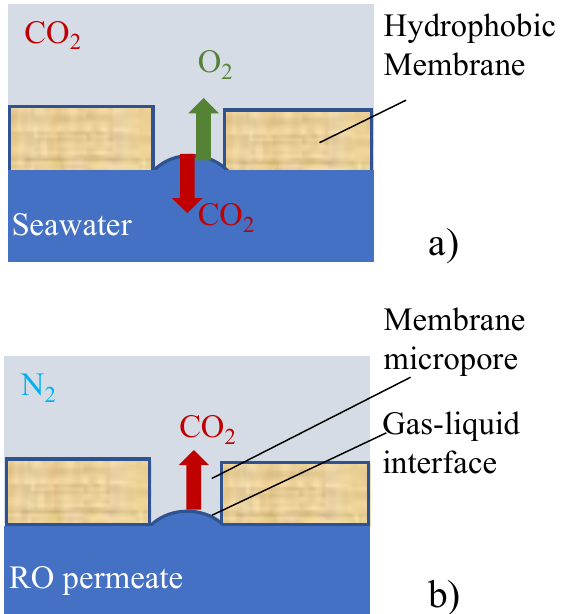
Figure 3. ( a ) Seawater pre-treatment and ( b ) RO permeate post-treatment by membrane contactors.